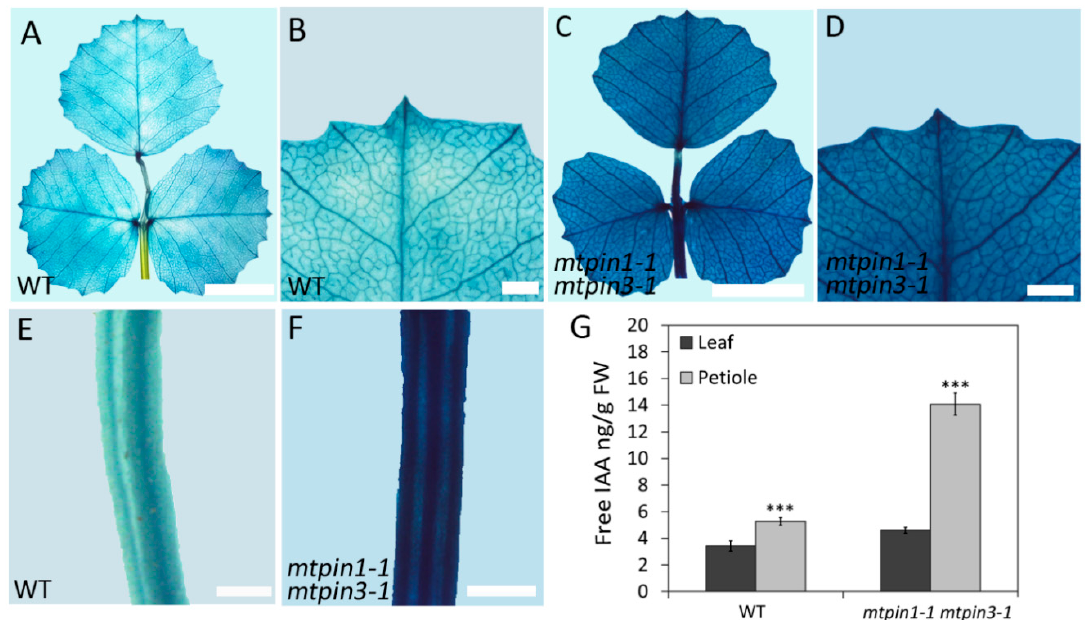
Figure 4. Auxin accumulated in leaf and petiole in mtpin1-1 mtpin3-1 . ( A , B ) DR5:GUS expression in adult leaf of wild-type. Close view is shown in ( B ). ( C , D ) DR5:GUS expression in adult leaf of mtpin1-1 mtpin3-1 . Close view is shown in ( D ). ( E , F ) DR5:GUS expression in petiole of wild-type and mtpin1-1 mtpin3-1 . ( G ) Measurement of free auxin content in leaf and petiole of 45-day-old wild-type (WT) and mtpin1-1 mtpin3-1 . Values are the means and SD of three biological replicates. *** p < 0.001. Bars = 1 cm in ( A , C ), 1 mm in ( B , D – F ).